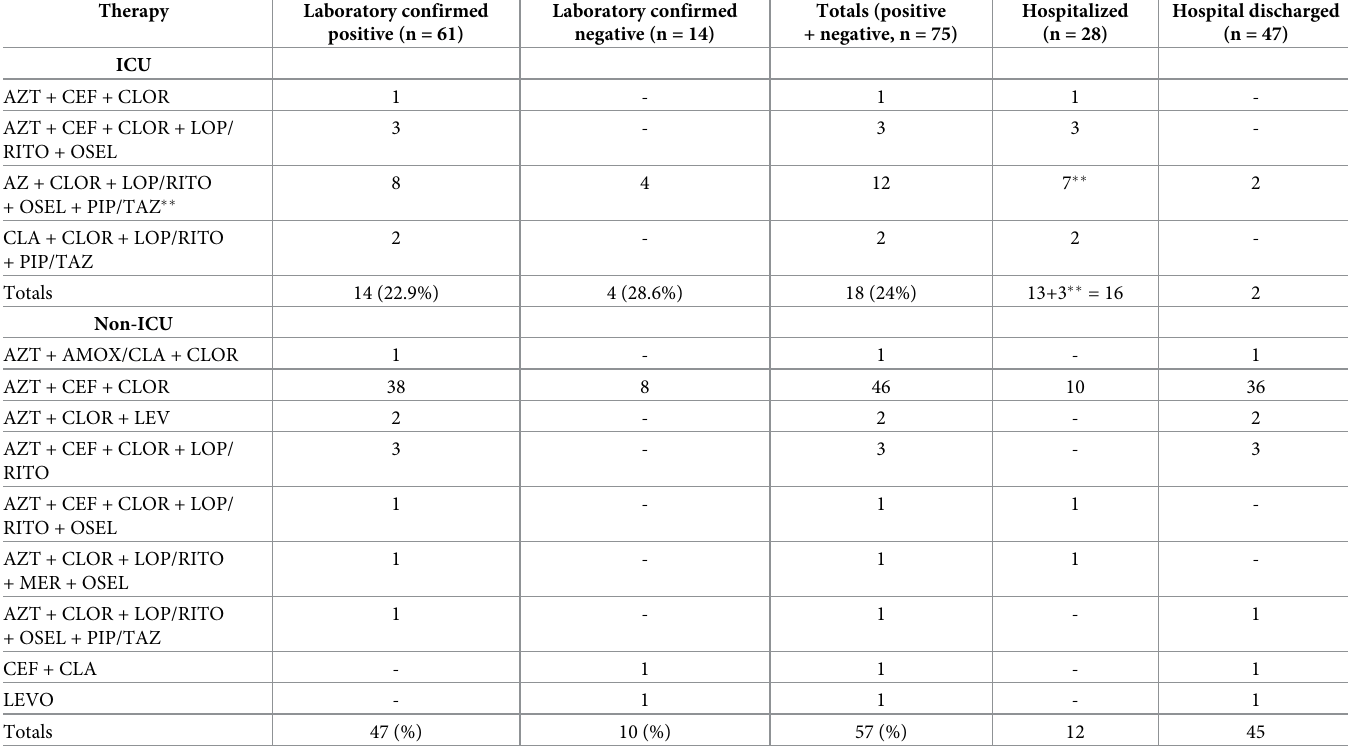
Outputs considered up to the end of data collection for intensive care unit (ICU; n = 14) or non-ICU (n = 47) cases that remained in the hospital or were discharged. Percentages are calculated in relation to the total number of laboratory confirmed cases (n =